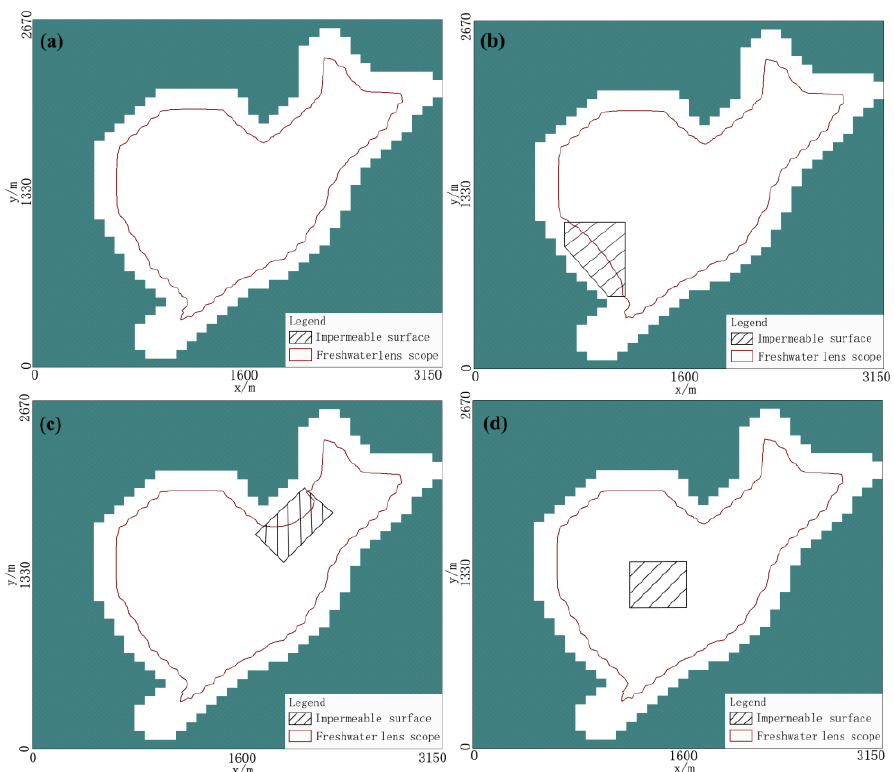
Figure 8. Scope of the freshwater lens in original condition ( a ); scope of the freshwater lens in three simulation scenarios, setting impermeable surfaces in the southwest, northeast and middle of the island ( b – d ).